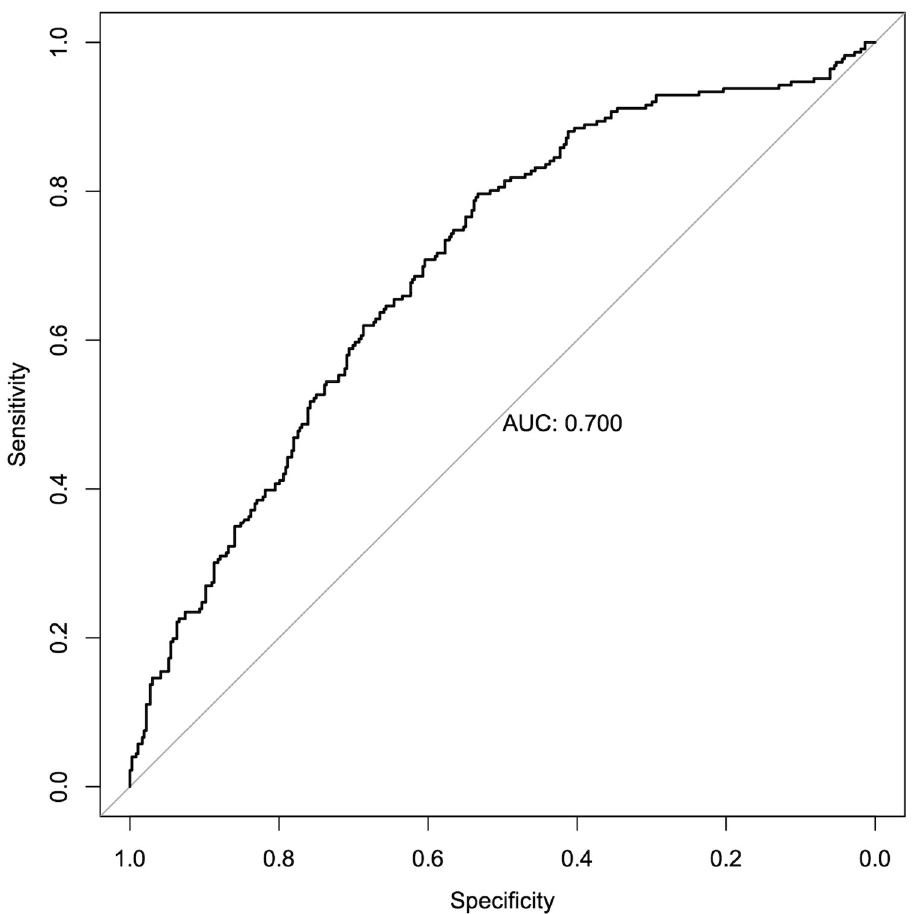
Fig 1. Receiver operating characteristic (ROC) curve of the prediction models. The black line depicts the ROC curve both for the ‘EXPORT’ as well as its monotonously transformed ‘calibrated EXPORT’ model. The sensitivity (y- axis) is plotted as a function of the specificity (x-axis). The area under the curve (AUC) is 0.700.